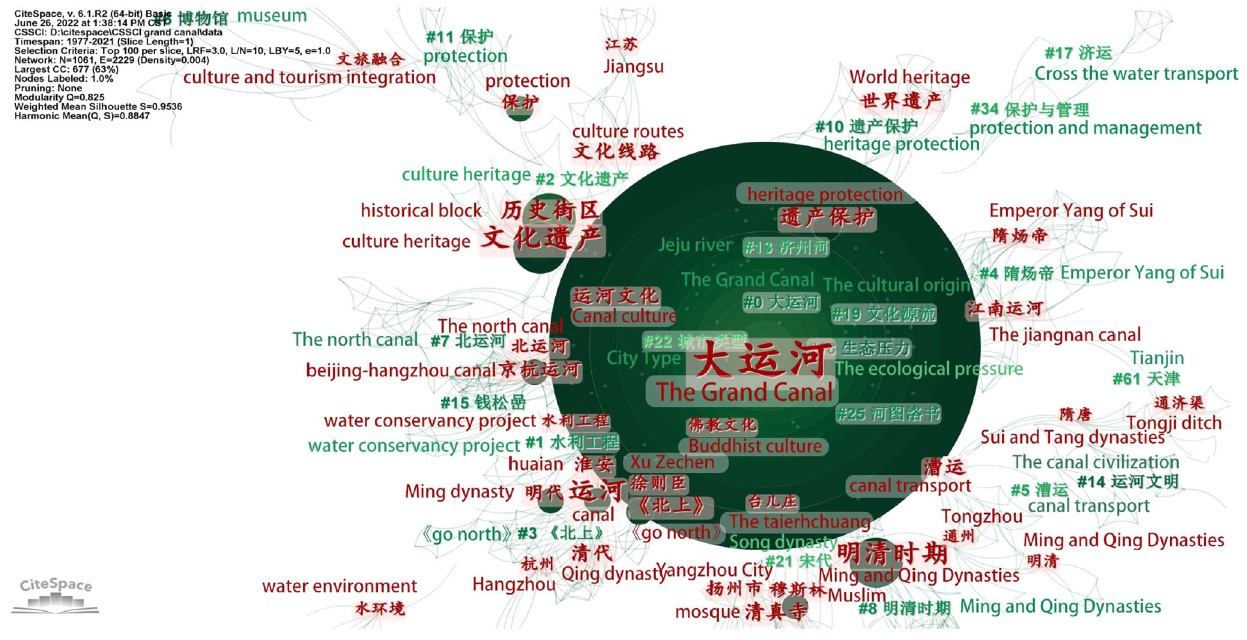
Fig. 10 Keywords and knowledge clusters of Grand Canal of China literatures in CSSCI database (1977 –